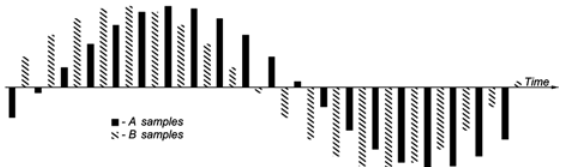
Fig. 2. An example of a sampled echo signal from a single object in the LFM-FSK radar Each sequence of samples A or B is processed sep- arately by using the Fourier transform in order to de- termine the frequency and phase of its sinusoidal envel- ope, which is seen as a peak in the spectral domain. After